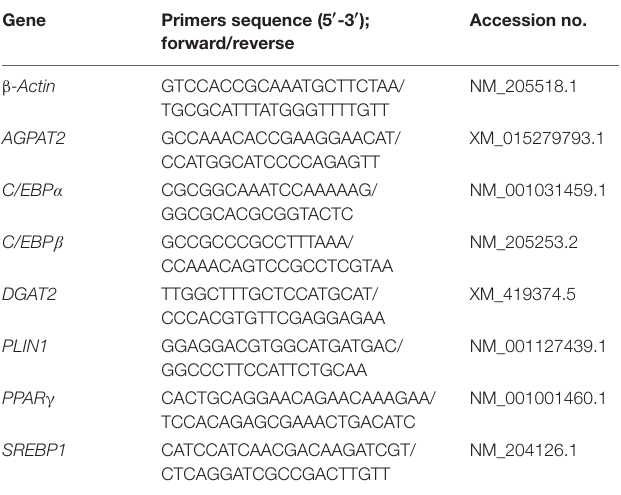
TABLE 1 | Primers used for real time PCR 1 .